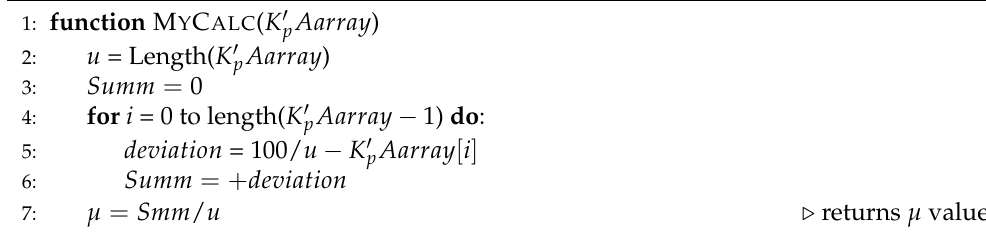
Algorithm 2 Calculation of the coefficient of deviation from the balanced state µ .